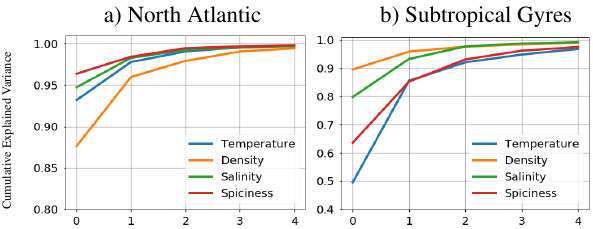
Figure 2. The cumulative explained variance for the PCA components of the training data for the a) North Atlantic and b) Subtropical